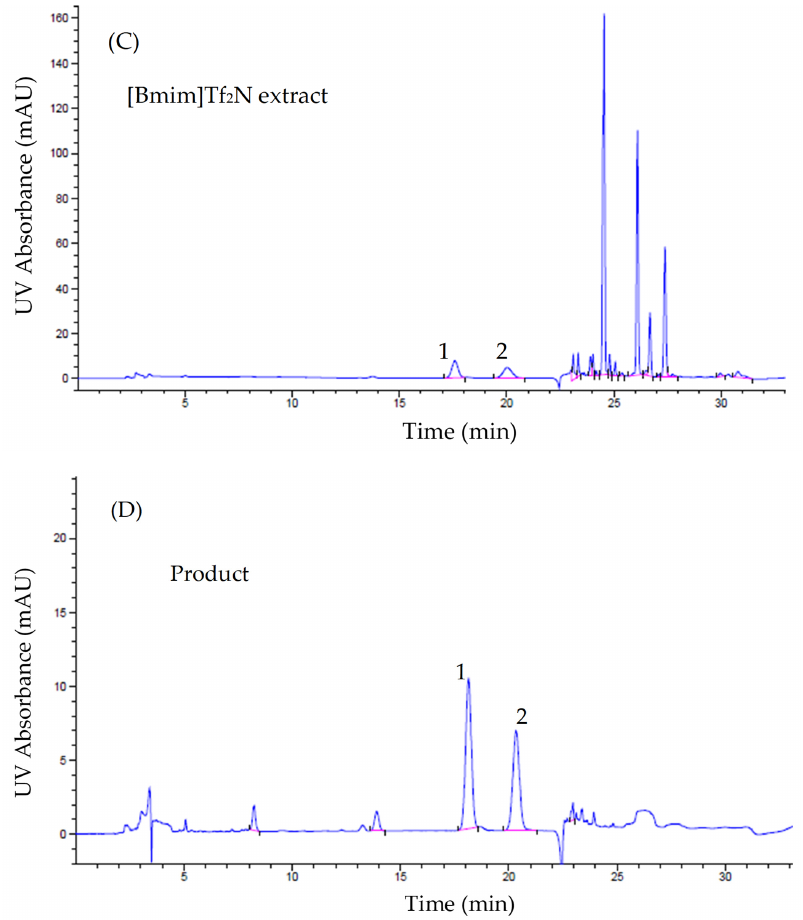
Figure 7. HPLC chromatograms of ( A ) oxypeucedanin hydrate standard, ( B ) byakangelicin standard, ( C ) [Bmim]Tf 2 N extraction solution and ( D ) product. (254 nm).